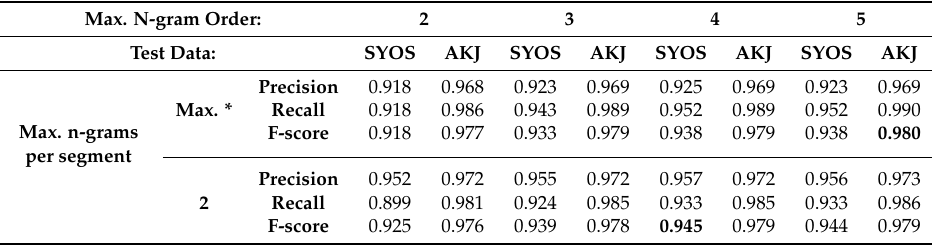
Table 5. Evaluation results—MiNgMatch Segmenter (best results in bold).